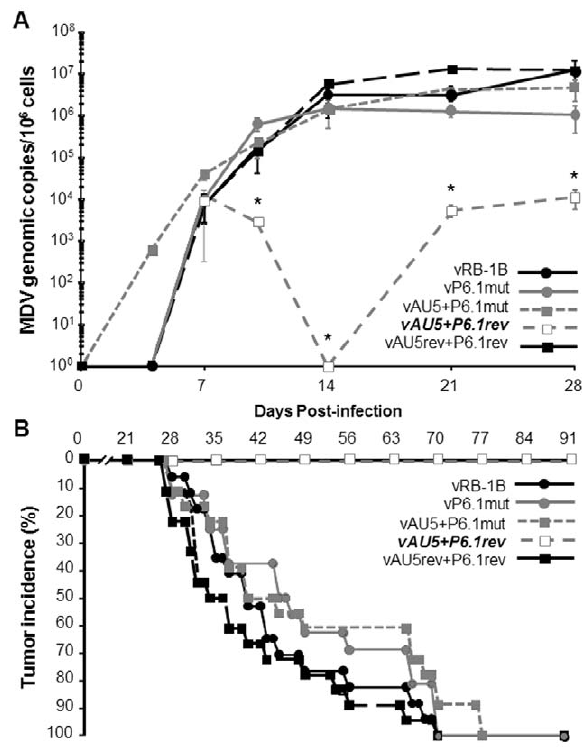
Figure 6. Secondary mutation of the vTR-TERT interaction domain, P6.1, rescues MDV replication and lymphomagenesis. MD-susceptible chickens were infected with vRB-1B (n=17), vP6.1mut (n=16), vAU5 + P6.1mut (n=18), vAU5 + P6.1rev (n=19), or vAU5rev + P6.1rev (n=18). A) DNA was obtained from blood of infected chickens and MDV genome copies are shown per 1 6 10 6 cells as in Fig. 3. Significant differences in genome copies between vAU5 + P6.1rev and vRB-1B (14dpi, p=0.013; 21dpi, p=0.004; 28dpi, p=0.049) and vAU5rev + P6.1rev (14dpi, p=0.002) are indicated with an asterisk (*) using Student’s t test. B) Tumor incidences for each group infected with viruses contained only the AU5 mutation (empty boxes), additional/ exclusively the P6.1 mutation (grey symbols) or parental and complete revertants (black symbols) were measured for 13 weeks.